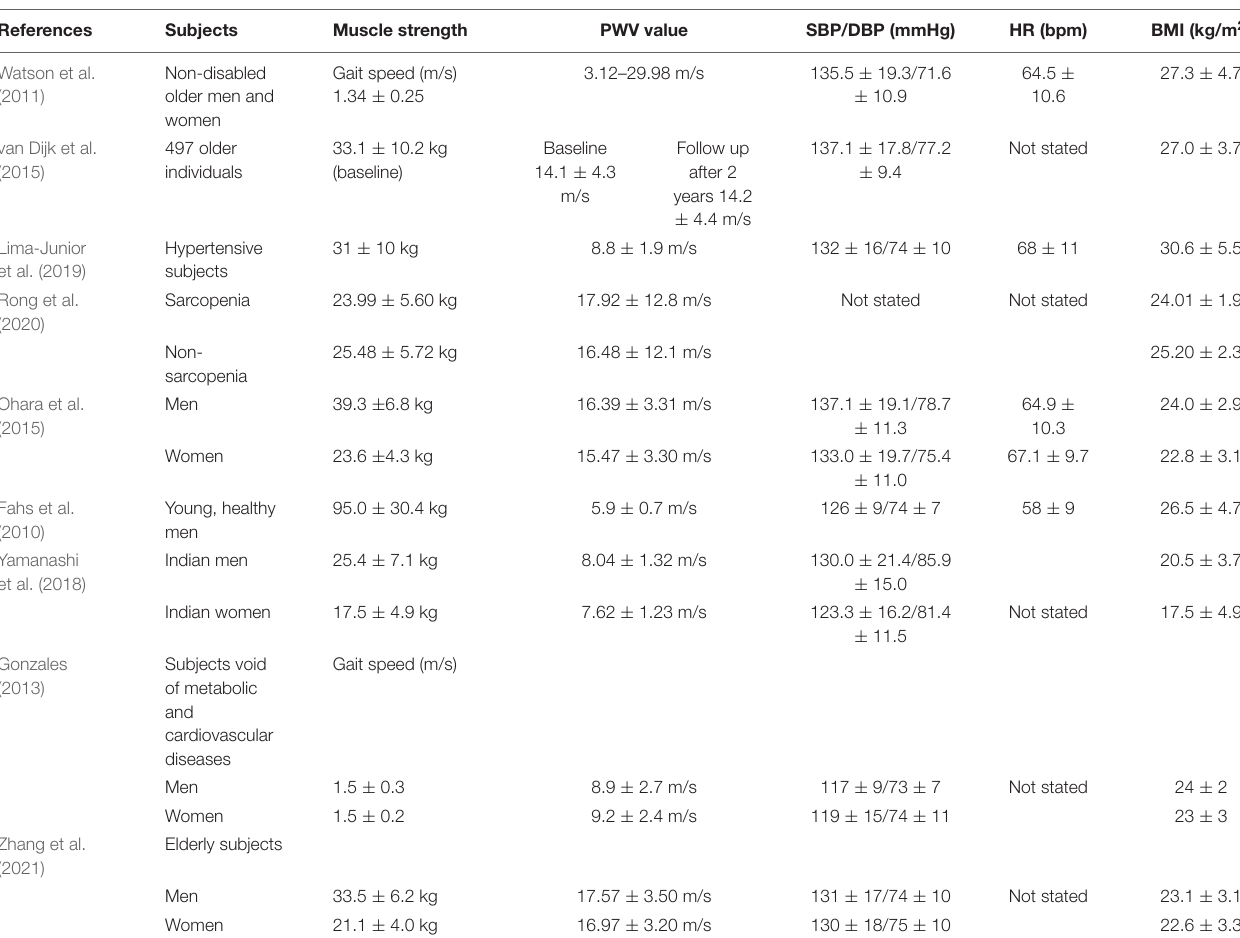
TABLE 4 | Values of related parameters in each study (muscle